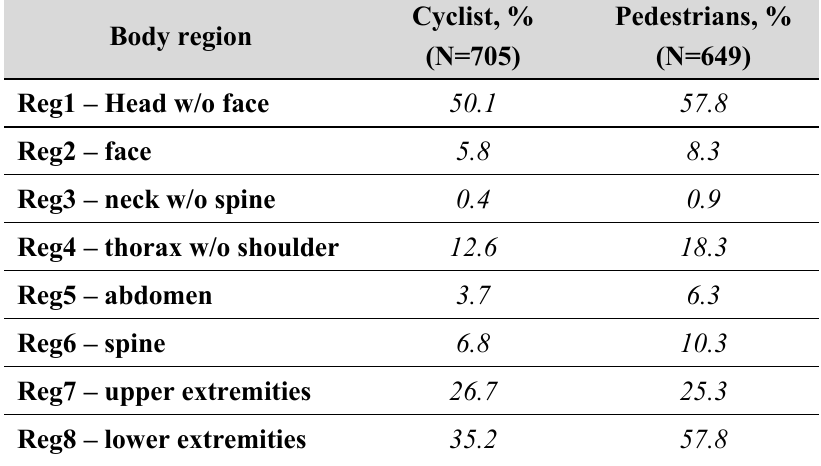
Table A3. Proportion of MAIS2+ injured cyclists and pedestrians sustaining MAIS2+ injuries in the listed body regions